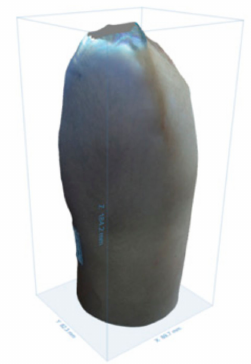
Figure 3. Three-dimensional model of the stump generated from Autodesk Recap Photo.